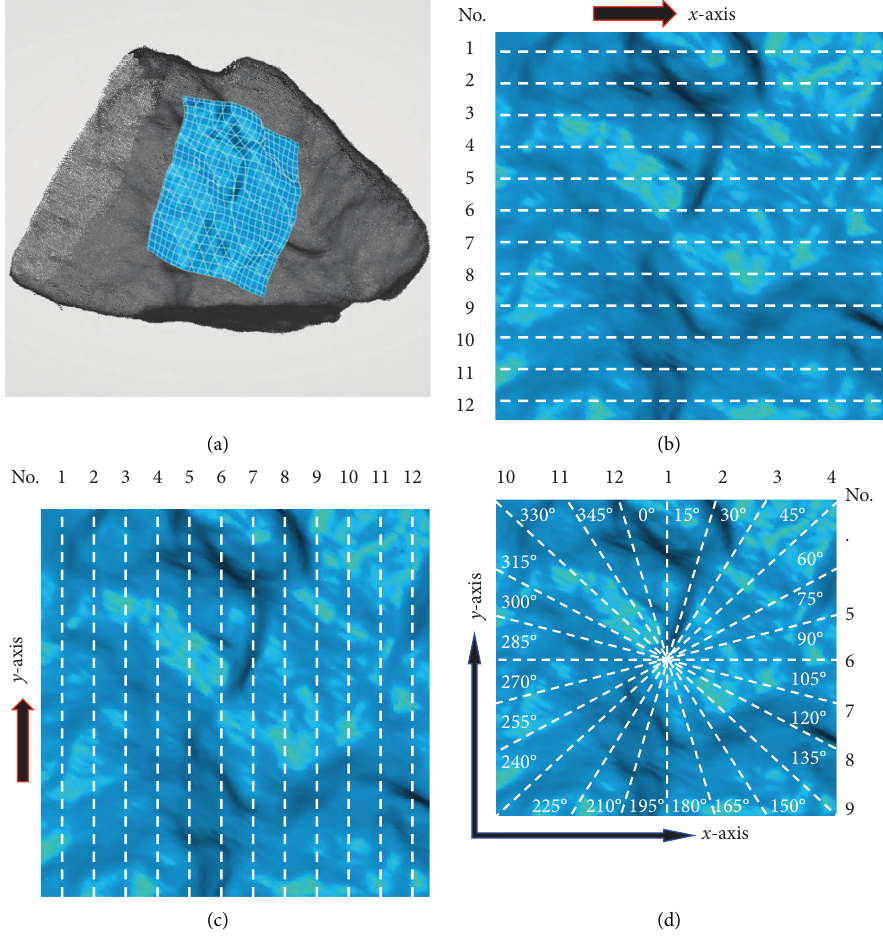
Figure 5: Observation sections of the aggregate surface. (a) Analysis area of the aggregate fracture surface. (b) 2D profile position distribution along the x -axis. (c) 2D profile position distribution along the y-axis. (d) 2D profile position distribution along the circumference.